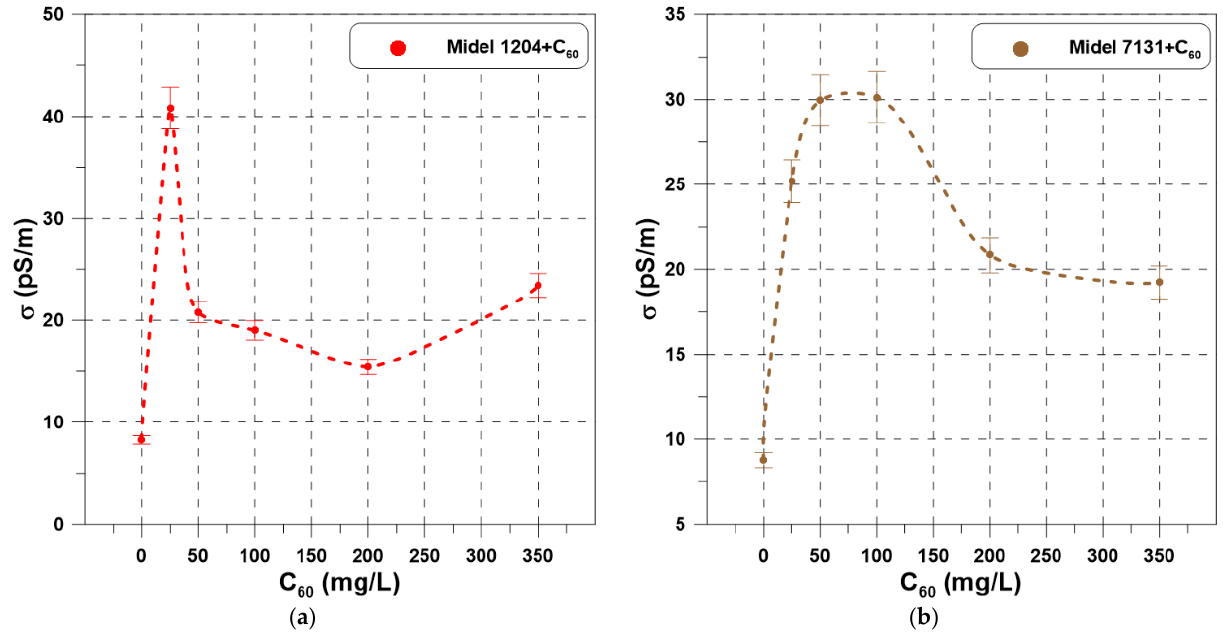
Figure 3. Conductivity of ( a ) Midel 1204 natural ester and ( b ) Midel 7131 synthetic ester versus concentration of C 60 .